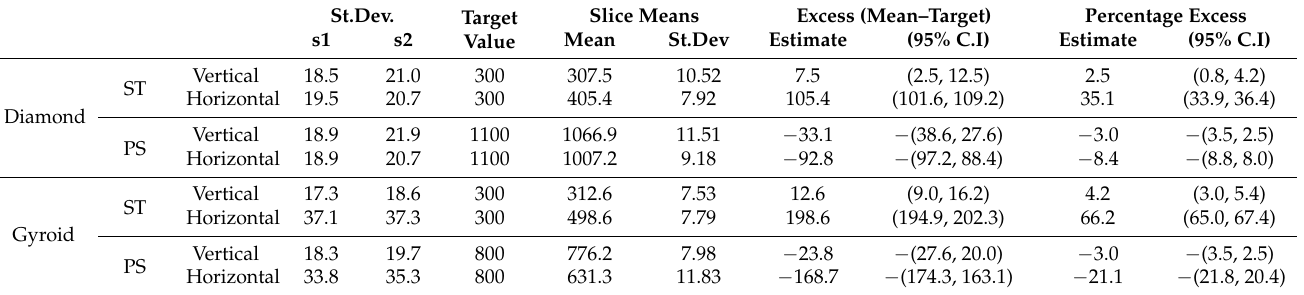
Table 4. Standard deviations of individual measurements at different locations in the same slice (s1) and in different slices (s2), and means and standard deviations of the 20 slice means for each combination of structure type, variable and strut orientation. The standard deviations of the slice means were each based on 15 degrees of freedom, calculated using one-way ANOVA (slices within replicates) of the slice means. Additionally, the estimates are given with 95% confidence intervals of the excess (mean minus target) in microns and the excess as a percentage of the target value. All quantities are in microns, except for the last two columns, which are